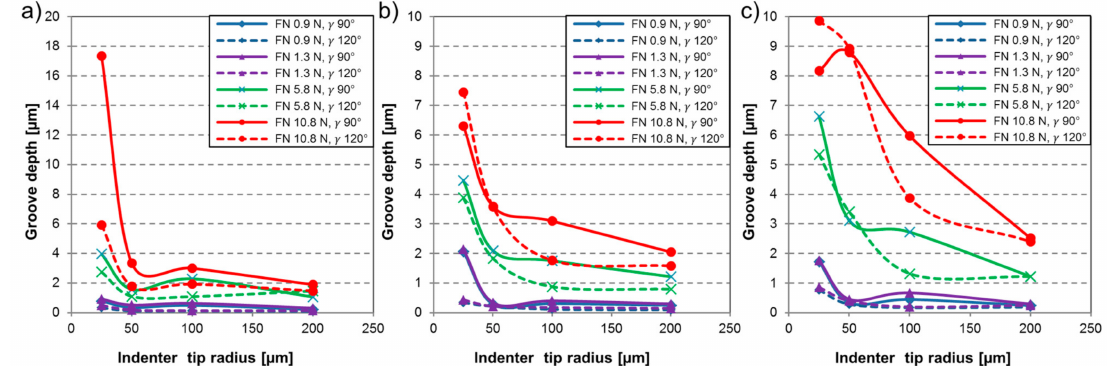
Figure 4. Depth of wear grooves [ µ m] in function of indenter tip radius [ µ m] with various applied load (F N ) and indenter cone angle ( γ ) for material ( a ) FM, ( b ) TM, ( c )